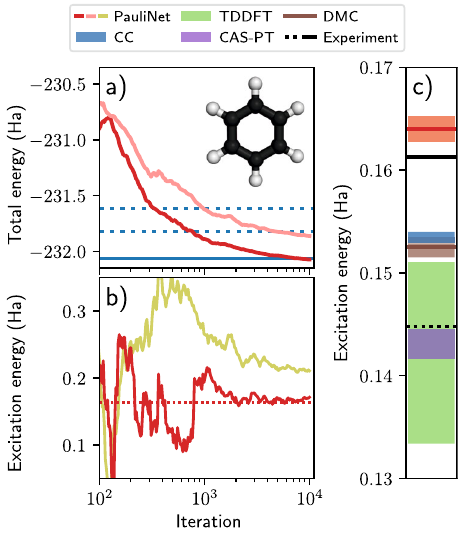
Fig. 4 | Calculating the two lowest electronic states of the benzene molecule. Inset: Benzene structure. a Convergence of the total energies of the ground state (red) and excited state (light red) with training. Total energies of the ground state from CCSD(T) in the frozen-core approximation with the aug-cc-pV n Z basis set ( n =D, T) (dashed blue), and full CCSD(T) at the CBS limit (solid blue) are shown 36 . b Convergence of the excitation energy with training (with (red) and without (yellow) variance matching). c Excitation energy computed using PauliNet, TDDFT 68 , CC 78 , DMC 26 , CAS-PT ( 79 and calculations in openMolcas 80 ) and Experiment 26,45 (adiabatic (dashed black) and vertical (solid black) excitation energies).(ThenumericaldatacanbefoundinSupplementaryTableIV;sourcedata are provided as a Source Data fi